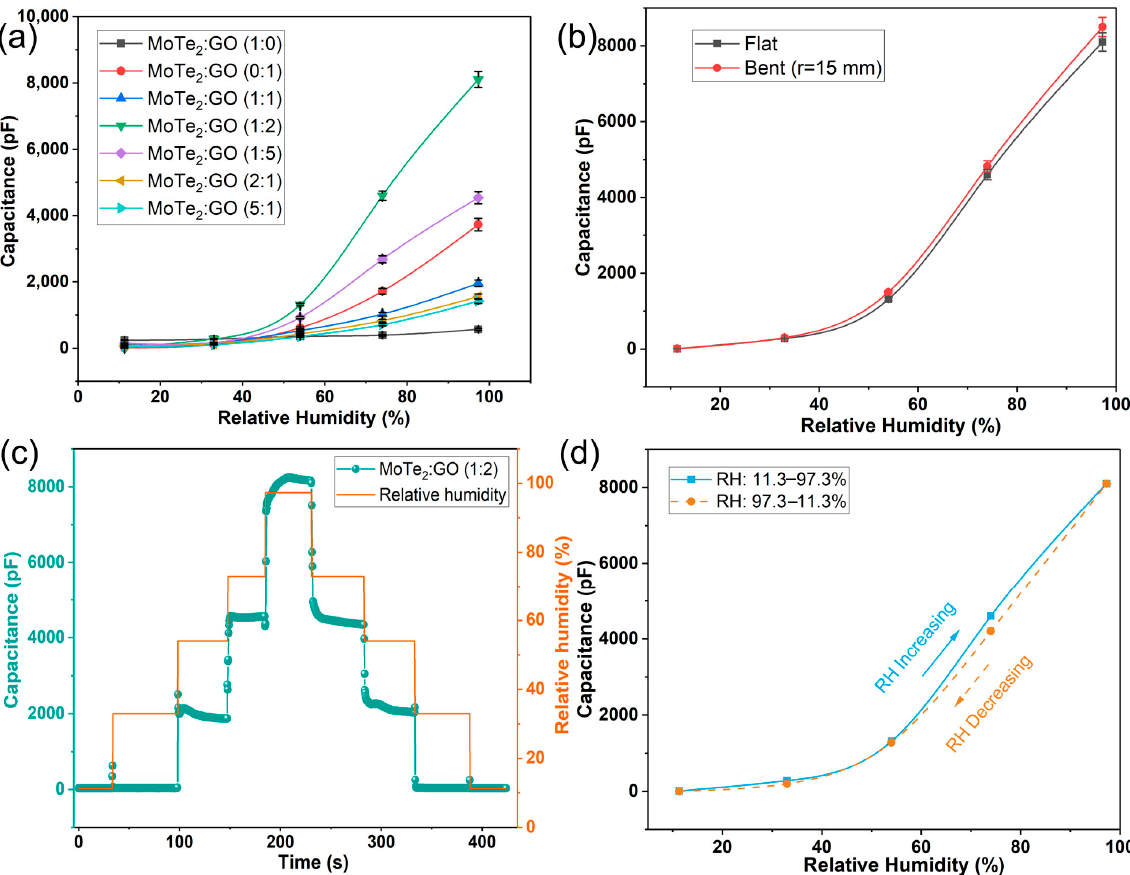
Figure 4. Humidity-sensing and flexibility performance of the sensor. ( a ) The humidity response of the capacitive MoTe 2 /GO sensors with different ratios from 11.3%RH to 97.3 %RH; ( b ) the capacitance changes of the sensor (MoTe 2 /GO = 1:2) as a function of relative humidity under flat and bent state; ( c ) the dynamic hysteresis loop curve of the sensor (MoTe 2 /GO = 1:2); ( d ) the typical adsorption response and desorption recovery curves of the sensor (MoTe 2 /GO =